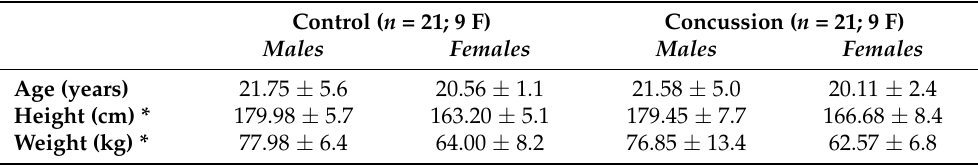
Table 1. Group characteristics.